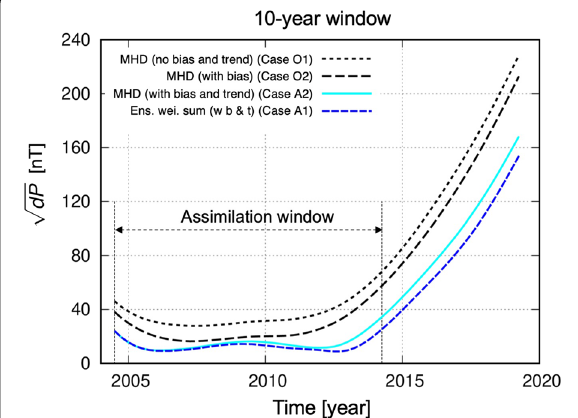
Fig. 5 Effects of the bias and trend terms on √ d P , defined by Eq. (40). The black dotted and dashed lines and the cyan solid 0 (Eq. 16), i.e., the MHD line indicate the MHD forecasts with k ′ = simulations given the initial condition at 2004.25 obtained by the data assimilation. The dotted black line is with neither bias nor trend, while the dashed line includes only bias. The cyan solid line takes both bias and trend into consideration in minimizing Eq. (10) at the final iteration. The blue dashed line shows the ensemble-weighted sum with bias and trend terms, corresponding to Eq. (13). See Table 1 for details of each